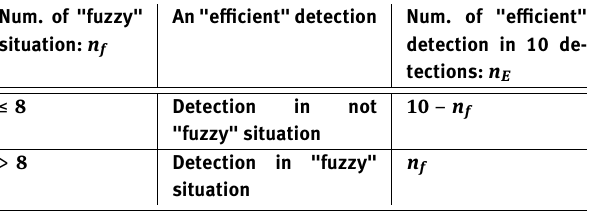
Table 2. Decision of "Efficient" Detection Num. of